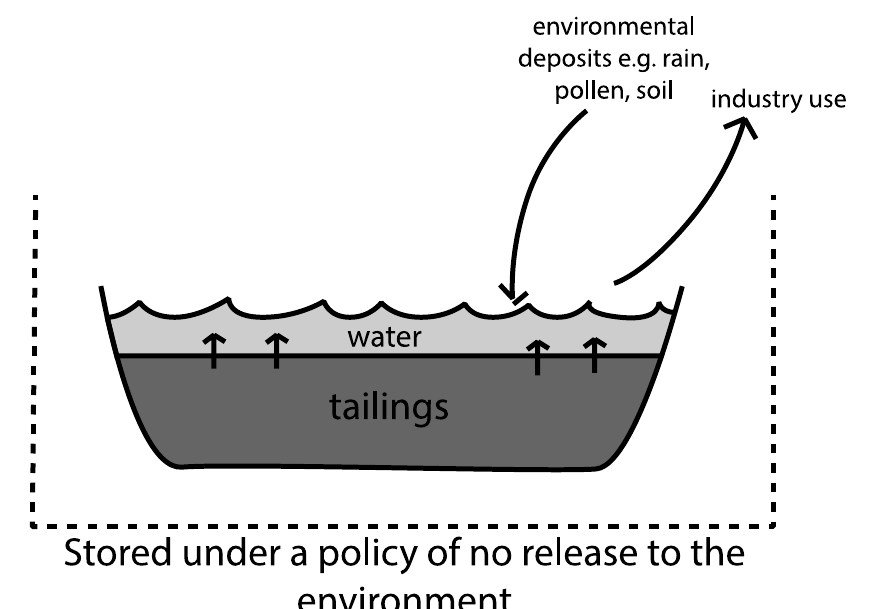
Figure 2. Simplified schematic of material flow between the local environment and a filled tailings pond.